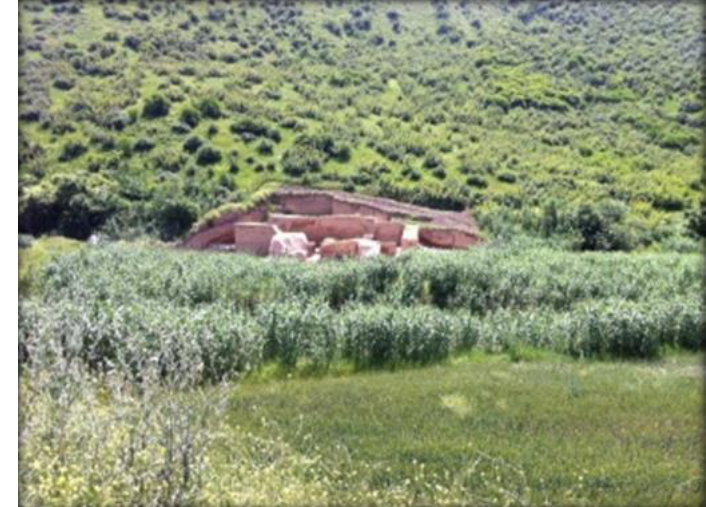
Figure 1. Prospect of the Great Wall of